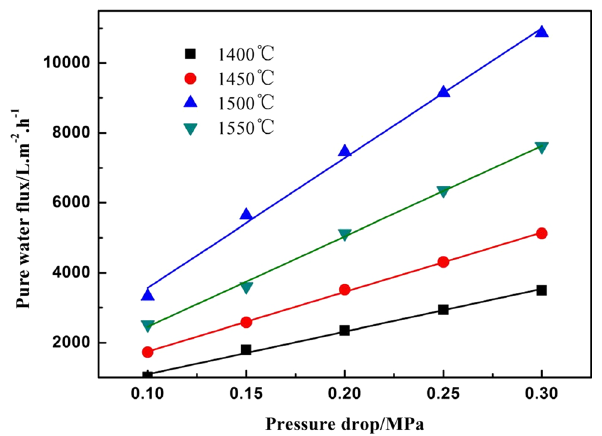
Fig. 7 Variation of pure water flux with applied pressures (0.1– 0.3 MPa) for the supports sintered at different temperatures (1400 °C–1500 °C)